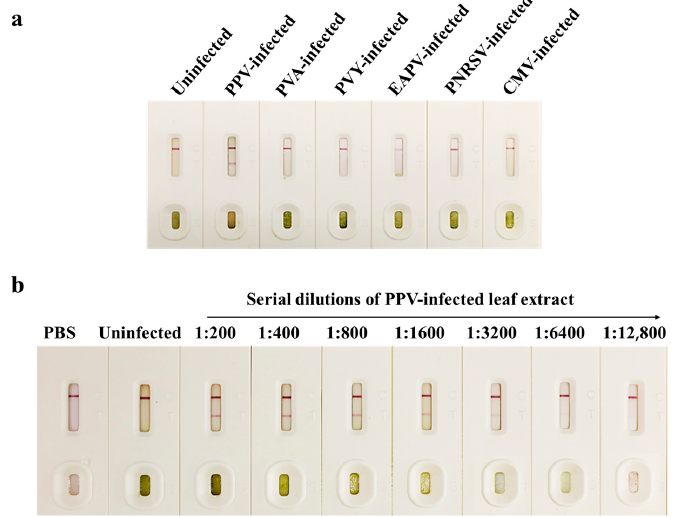
Figure 4. Specificity and sensitivity analyses of the CGICS. ( a ) Specificity of the CGICS was determined using crude extracts from a PPV-infected, other five virus-infected, and an uninfected tissue sample, respectively. ( b ) Sensitivity of the CGICS was determined using serially diluted PPV-infected leaf crude extract. The crude extract from an uninfected Japanese apricot tree leaf sample was used as the negative control. In this test, the 1:200 to 1:6400 diluted extracts produced a red band at the T line.